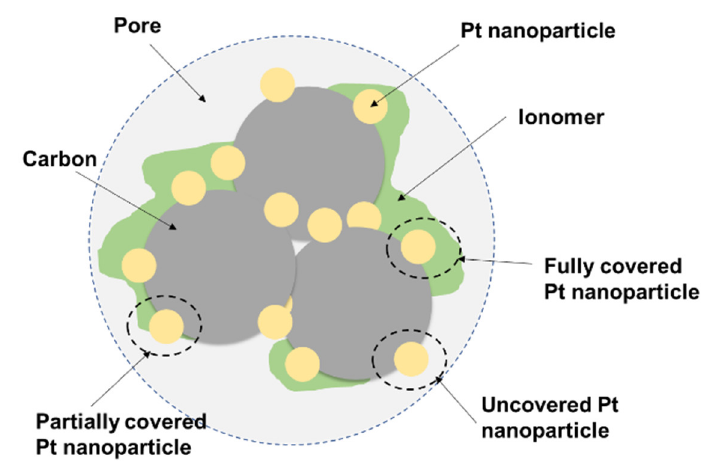
Figure 2. Illustration of ionomer-coated catalyst agglomerate [21,45].